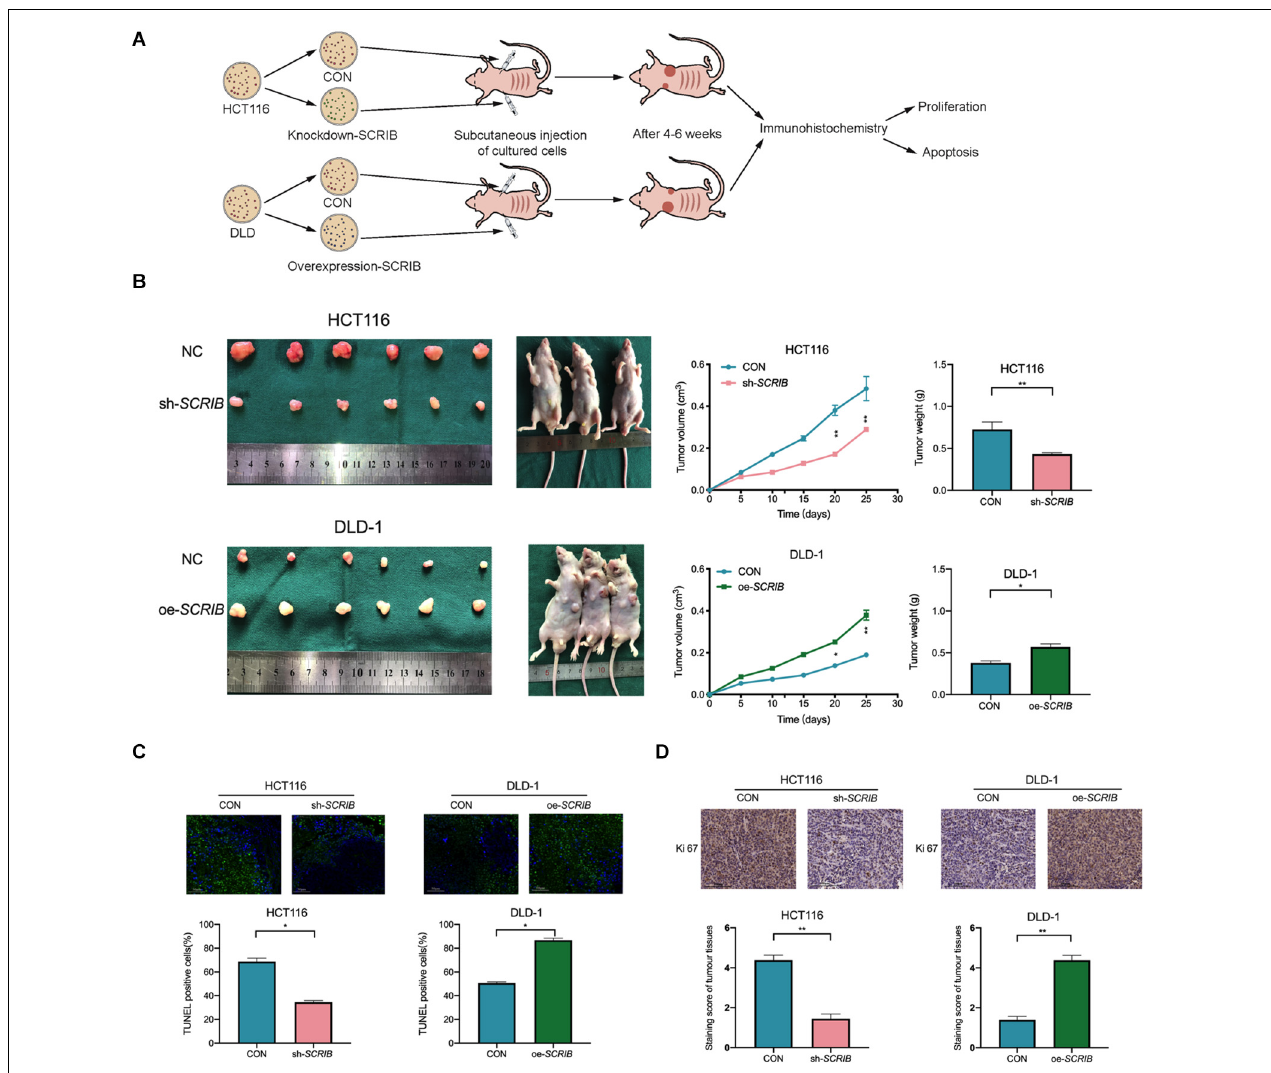
FIGURE 4 | SCRIB enhances tumour growth in vivo . (A) Nude mice were subcutaneously injected with HCT116 cells transfected with lentivirus and DLD-1 cells transfected with overexpression plasmid and their corresponding control cells. The established tumours in the right and left groins of the mice were measured every 5 days, and the mice were sacrificed 4–6 weeks after implantation. (B) Knockdown of SCRIB inhibited the tumour growth of HCT116 cells in nude mice, while overexpression of SCRIB promoted the tumour growth of DLD-1 cells in nude mice. (C) Apoptotic cells in tumour tissue were detected by TUNEL assay, and the number of TUNEL-positive cells was quantified; scale bars: 50 µ m. (D) Protein levels of Ki67 in the tumour samples were determined by IHC, scale bars: The data are shown as the mean ± SD of three independent experiments, * P < 0.05, ** P <